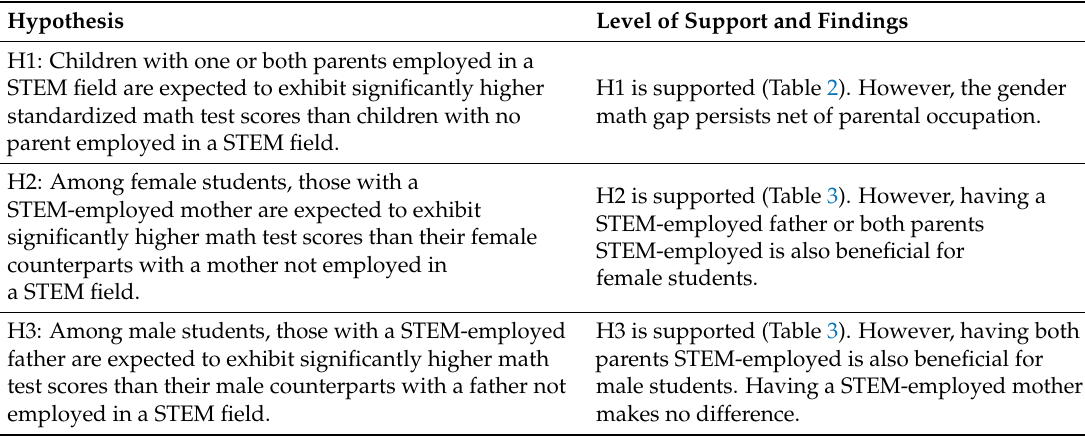
Table 4. Summary of results in relation to